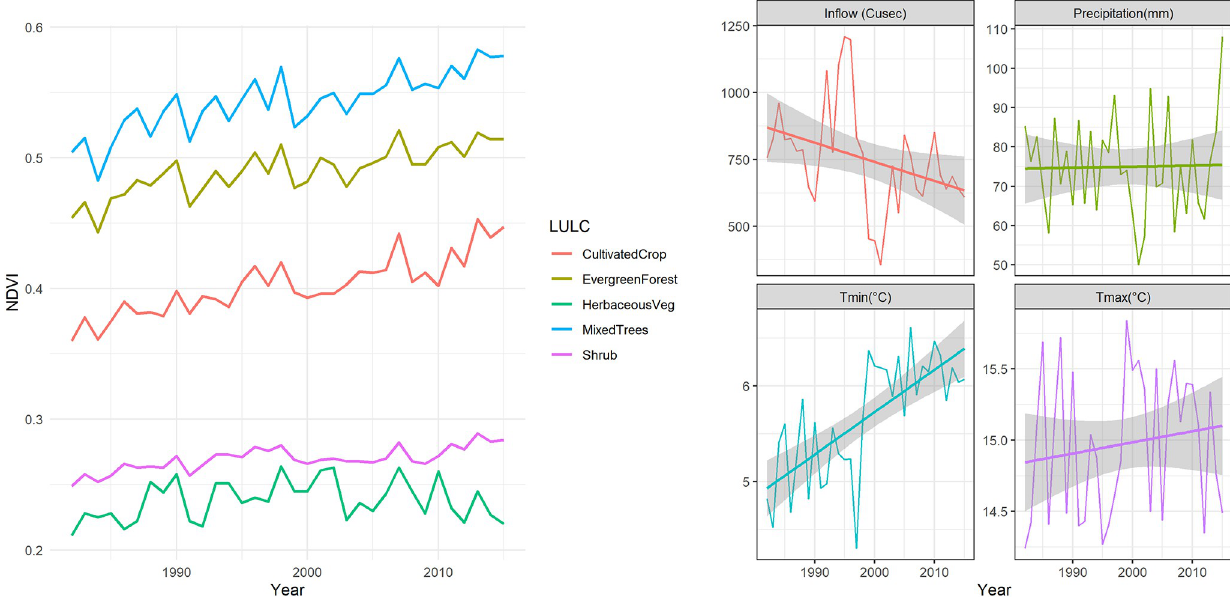
Fig 2. Average annual NDVI and hydrometeorological data variability during